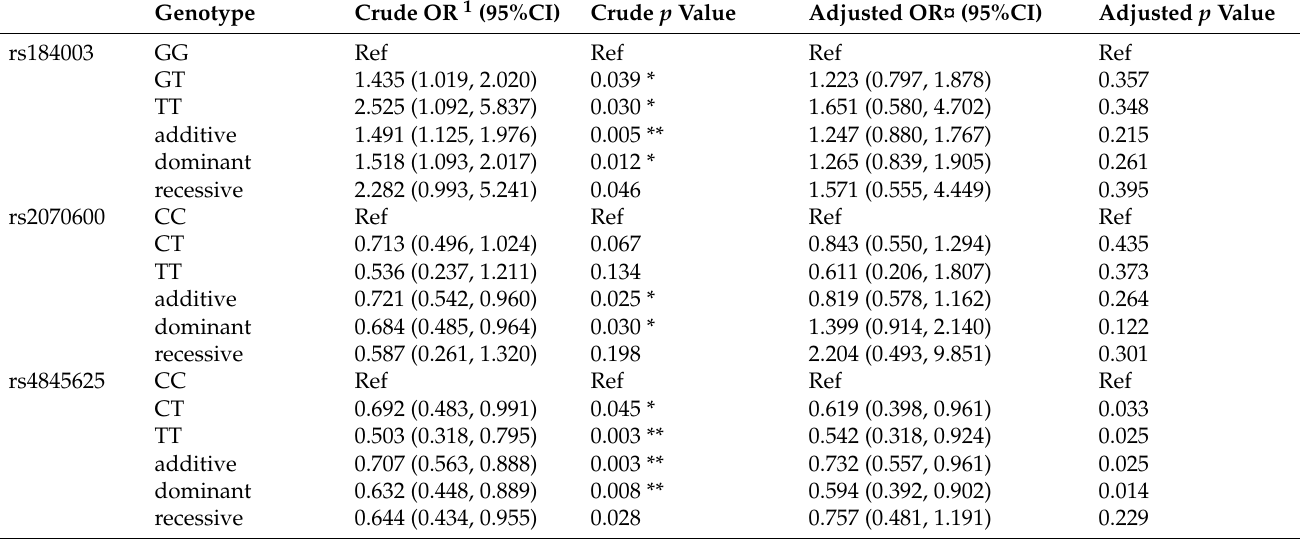
Table 2. Associations ofrs184003, rs2070600, and rs4845625with the riskof diabeticcardiovascular